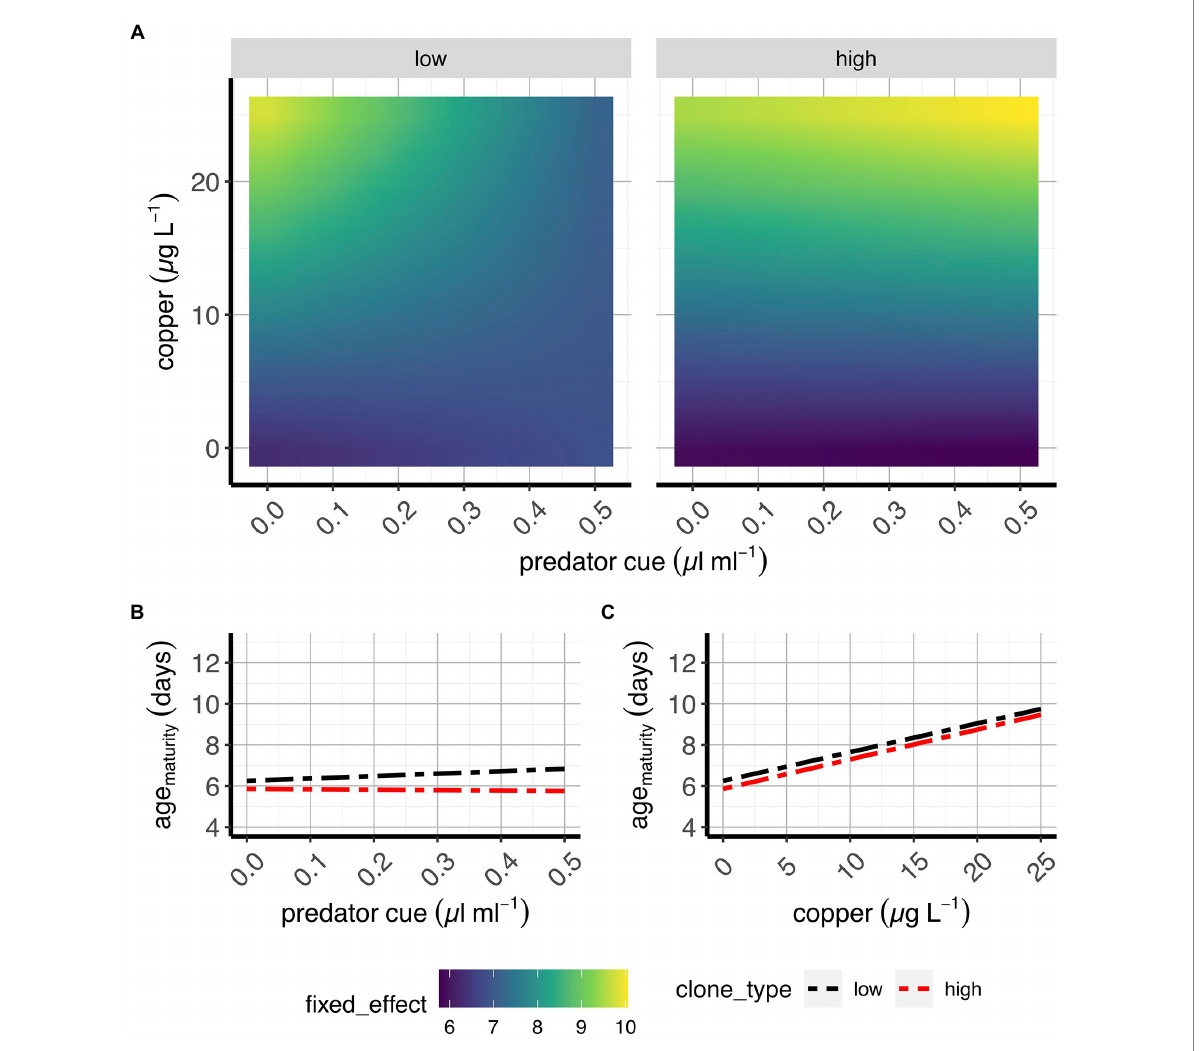
FIGURE 5 Age at maturity in two classes of D. pulex genotypes. (A) Contour plots of the average fixed effects portion of the model showing the overall response (here: age at maturity) to copper and predation in “high inducers” and “low inducers.” (B,C) Average effects of risk of predation (B) and sub-lethal copper concentrations (C) on age at maturity when copper and risk of predation, respectively, are absent (e.g., references for each treatment). X-axes present predator cue (A,B) or copper concentrations (C) , and y-axis denote copper concentrations (A) or age at maturity estimates (B,C)